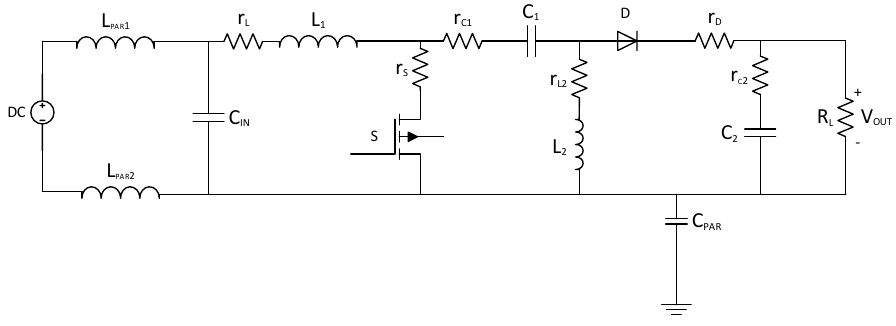
Figure 3. Model of SEPIC converter including non-ideal components.